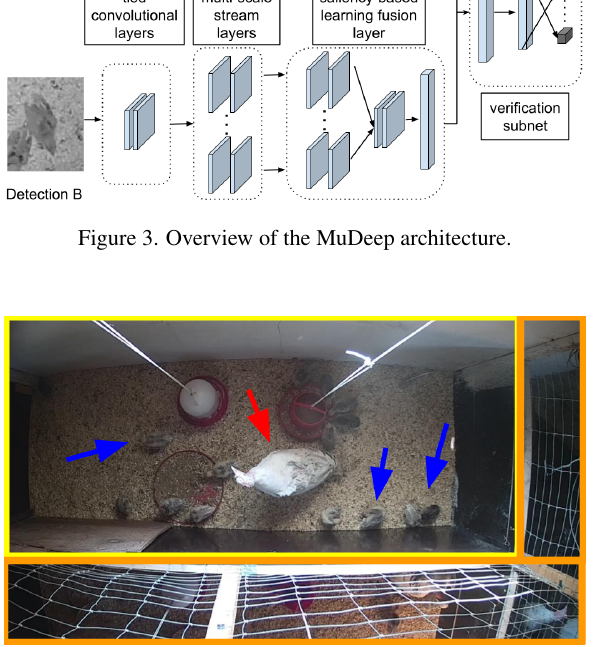
video sequences. Each video sequence is recorded via a